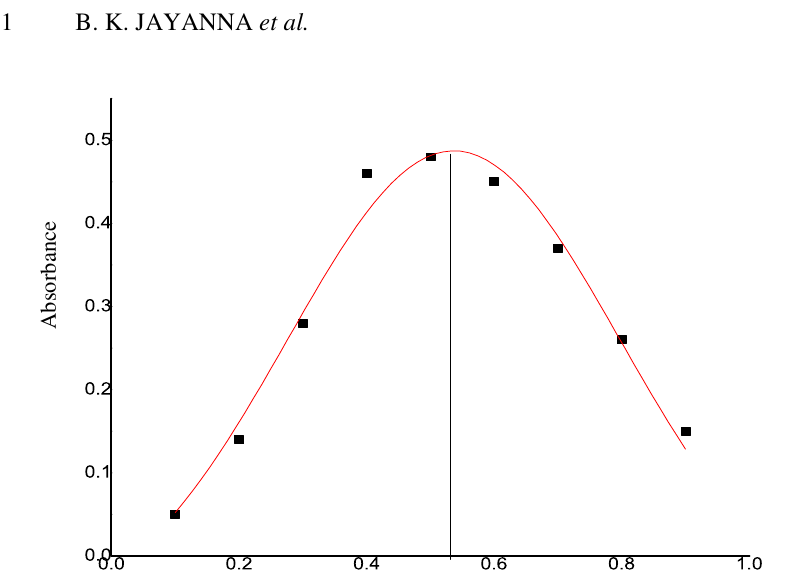
Figure 4. Continuous variation method, [promethazine hydrochloride]:0.001 M [Iodine monochloride]: 0.001 M and Co(II) =0.001 M